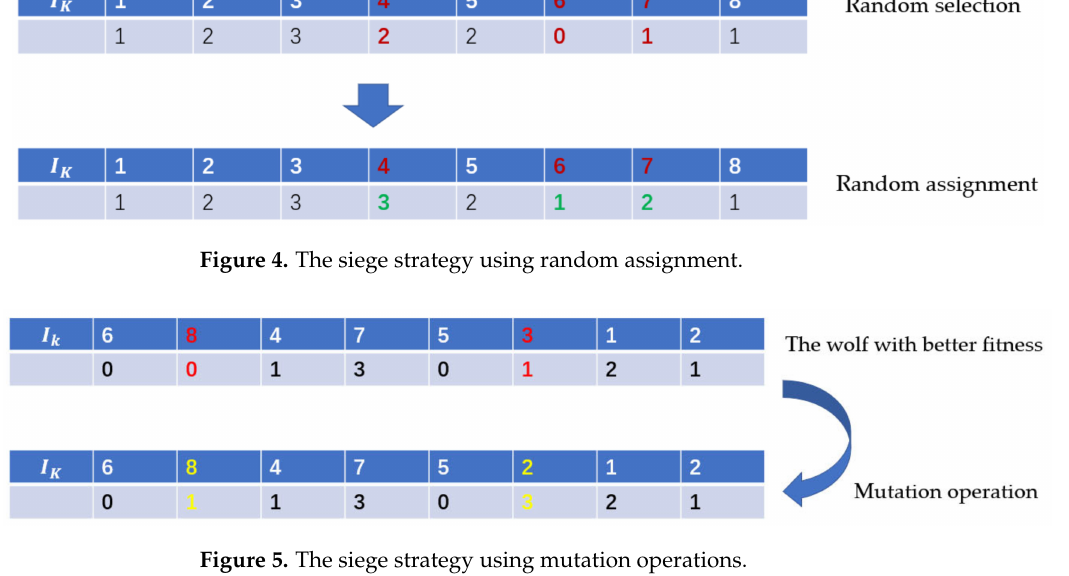
Figure 5. The siege strategy using mutation